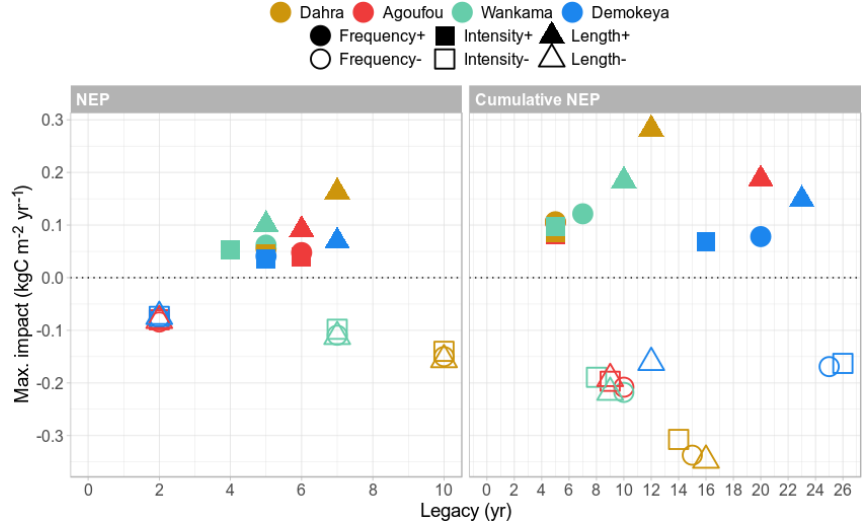
Figure 10. Summarized overview of the net ecosystem flux response to the different rainfall scenarios for all sites, showing the impact on the net ecosystem productivity (NEP) and the cumulative NEP. Different sites are represented by different colours, while the symbol shapes represent the applied